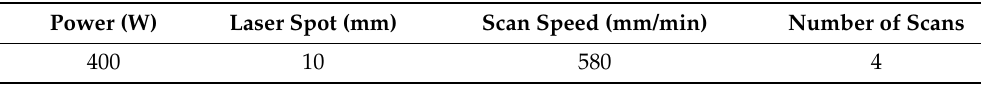
Table 4. Summary of preheating parameters in simulation.